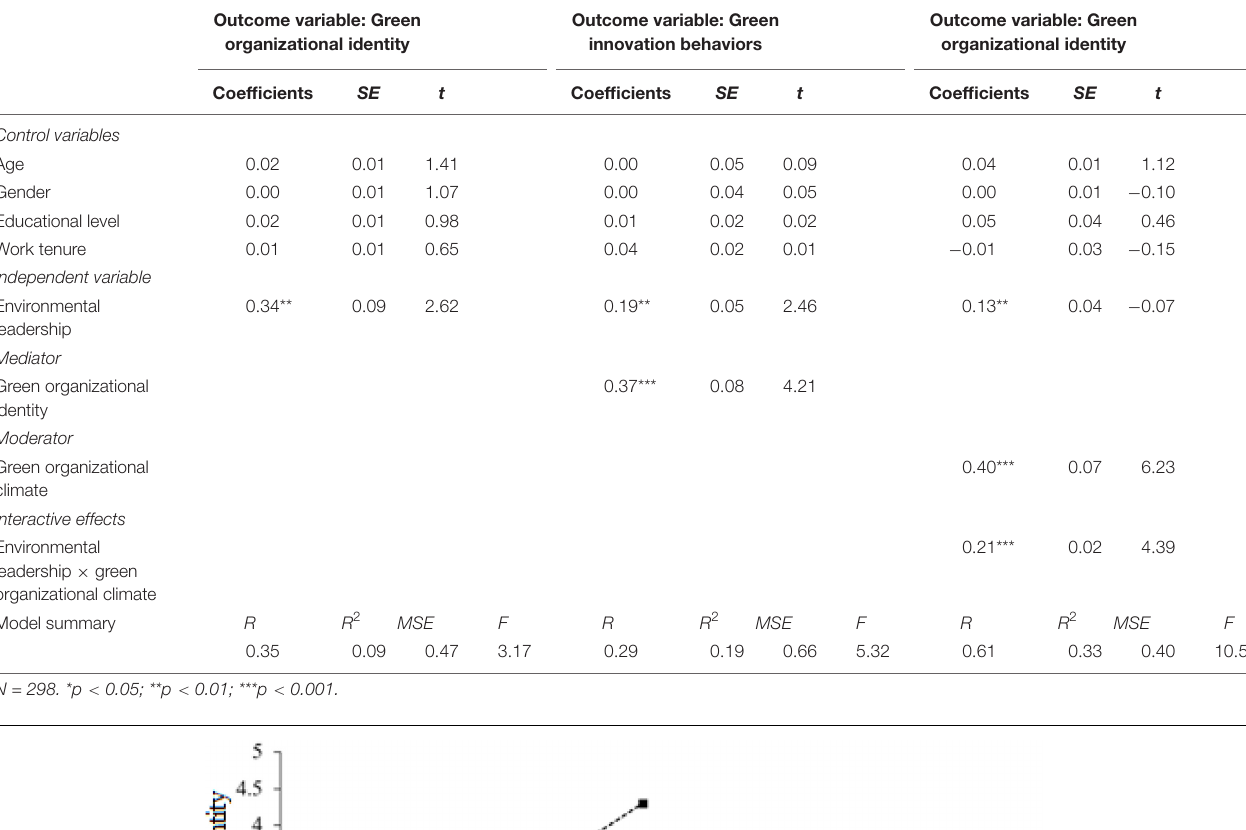
TABLE 4 | Results of the moderated regression analyses. Outcome variable: Green organizational identity